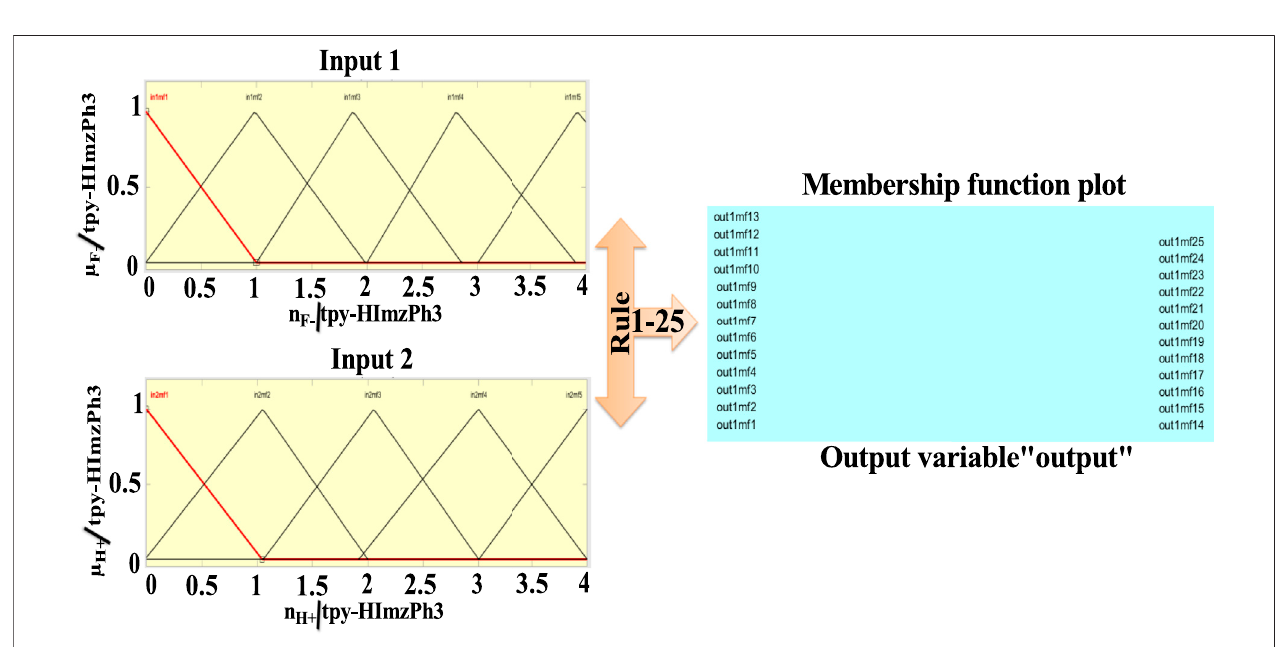
FIGURE 11 | Schematic presentation of ANFIS based on Sugeno ’ s method maintaining 25 rules.